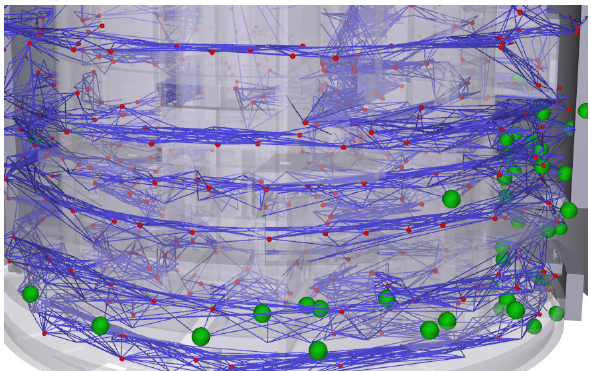
Figure 3 : 3D network used in the adjustment phase of the registration of laser scans, composed of scan stations (red), measurement of registration spheres from these stations (blue lines) and datum spheres for referencing